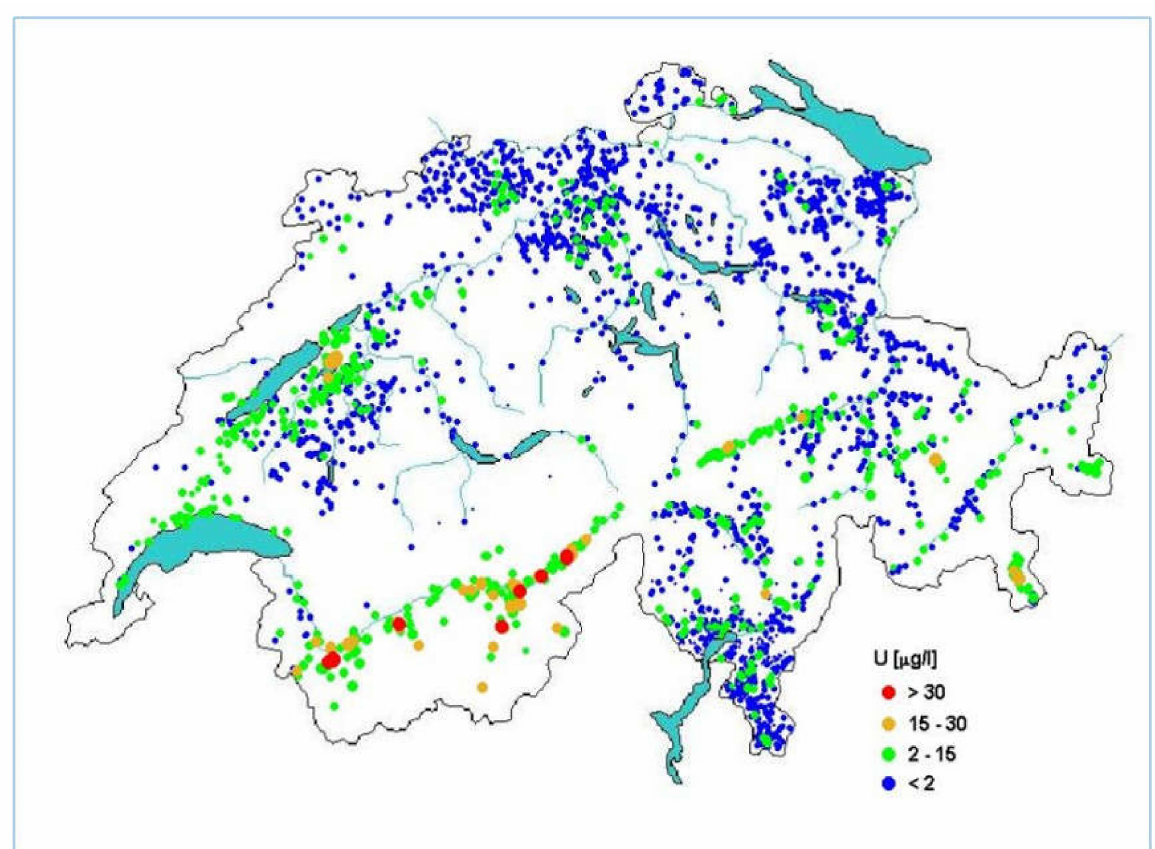
Figure 1. Concentrations of Uranium in Swiss tap water ( µ g/L). Taken from Natürliche Radioaktivität im Schweizer Trinkwasser (published in [7] with kind permission of Heinz